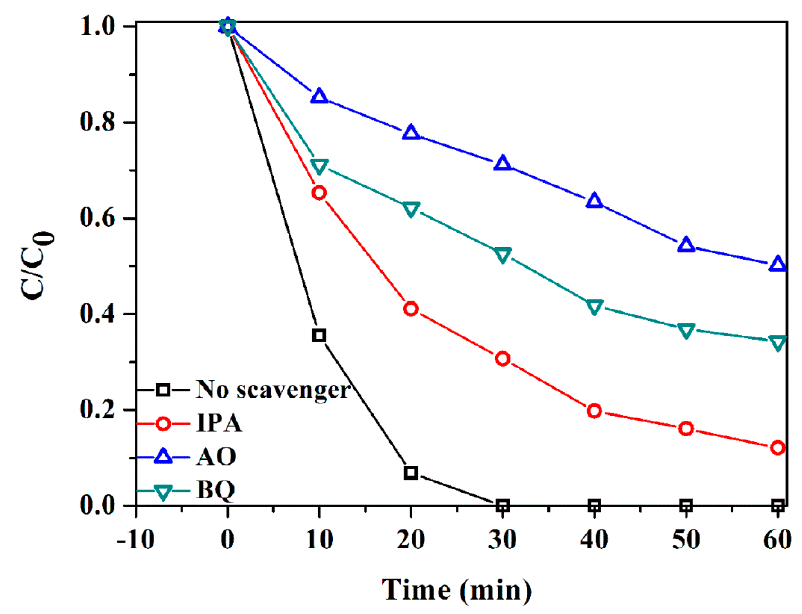
Figure 8. Radical–scavenge tests in the removal of RhB in the presence of ACO/BOCH-100.